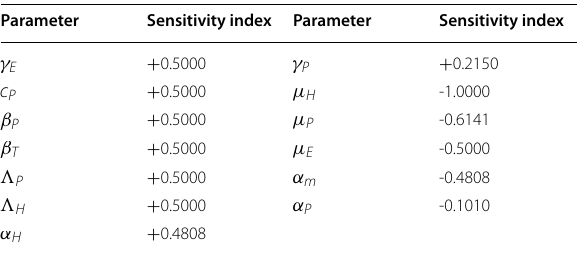
Parameter Sensitivity index